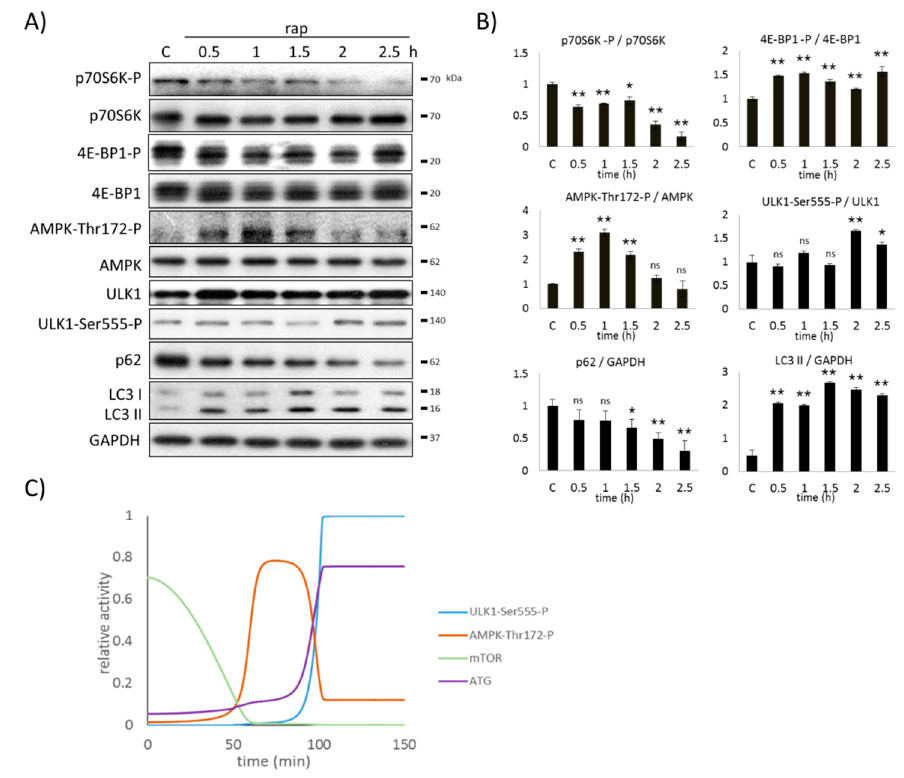
Figure 4. AMPK induction precedes ULK1 activation upon rapamycin treatment. HEK293T cells were denoted in time after 100 nM rapamycin treatment. ( A ) The markers of autophagy (LC3, p62), AMPK, ULK1 (ULK1-Ser555-P), and mTOR (p70S6K-P, 4E-BP1-P) were followed by immunoblotting. GAPDH was used as the loading control. ( B ) Densitometry data represent the intensity of p62 and LC3 II normalized for GAPDH, ULK1-Ser555-P normalized for the total level of ULK1, p70S6K-P normalized for the total level of p70S6K, 4E-BP1-P normalized for the total level of 4E-BP1, and AMPK-Thr172-P normalized for the total level of AMPK. For each of the experiments, three independent measurements were carried out. Error bars represent standard deviation, asterisks indicate statistically significant di ff erence from the control: ns—nonsignificant; * p < 0.05; ** p < 0.01. ( C ) Computer simulation of rapamycin treatment. The relative activity of AMPK-Thr172-P, mTOR, ULK1-Ser555-P and autophagy (ATG) are plotted in time.